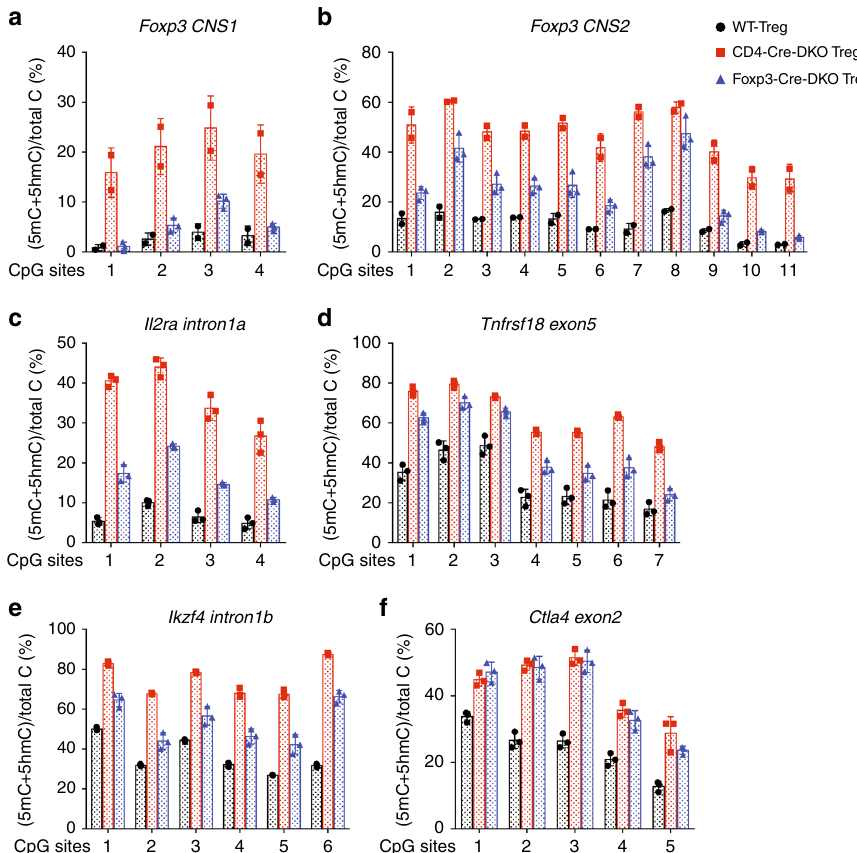
Fig. 3 DNA methylation status of TSDRs in WT and Tet2/3 fl / fl Foxp3 Cre DKO Treg cells. a – f DNA methylation status of TSDRs (Treg-speci fi c demethylated regions). Graphs depict the percentage of 5mC + 5hmC determined by BS-seq in peripheral Tregs in: ( a ) 4 CpGs in Foxp3 CNS1 , and ( b ) 11 CpGs in Foxp3 CNS2 , ( c ) 4 CpGs in Il2ra intron 1a , ( d ) 7 CpGs in Tnfrsf18 exon 5 , ( e ) 6 CpGs in Ikzf4 intron 1b and ( f ) 5 CpGs in Ctla4 exon 2 . Error bars show mean ± s.d. of thousands of sequencing reads from two independent experiments. Wild type (WT) Treg cells (8 – 10 weeks-old) are shown in black, CD4 Cre mediated Tet2/3 DKO Treg cells (3 – 4 weeks-old) are shown in red 12 and Foxp3 Cre mediated Tet2/3 DKO Treg cells (8 – 10 weeks-old) are shown in and a fold change ≥ 1.5, 2073 genes were differentially expressed, the level of active caspase-3, an early stage apoptosis marker, in with 1449 genes being upregulated and 624 genes being Treg cells from Tet2/3 fl / fl Foxp3 Cre mice compared to WT mice downregulated in Tet2/3 DKO Treg cells compared to WT Treg (Supplementary Fig. 10). Analysis of the TCR repertoire using cells (Supplementary Fig. 8a). A handful of them overlapped with RNA-seq reads mapping to the CDR3 region at Tcrb showed the differentially expressed genes from Tet2/3 DKO vs WT Treg greater clonal expansion in both Treg cells and CD4 + Foxp3 − cells isolated from Tet2/3 fl / fl Foxp3 Cre compared to WT mice cells isolated from pooled spleen and pLNs (Supplementary (Supplementary Fig. 11 and Supplementary Data 4 and 5), Fig. 8b). IPA analysis of the differentially expressed genes suggesting antigen-driven expansion. indicated that similar canonical pathways were affected, including Compared to WT mice, expression of genes involved in Tfh genes involved in cell cycle, DNA damage, immune cell function, differentiation, including Gzmb , Pdcd1 , Bcl6 , Maf , Cxcr5 , and and cancer development (Supplementary Fig. 8c and Supple- Il21 , was unaltered or only mildly increased in Treg cells isolated mentary Data 3). from the Tet2/3 fl / fl Foxp3 Cre mouse with moderate splenomegaly (DKO), but markedly increased in Treg cells isolated from the littermate mouse with more severe splenomegaly (DKO*) (Fig. 4e, left panel). Genes related to Tfh and Th17 cell differentiation (Il17a, Il17f, Rorc) in CD4 + Foxp3 – T cells displayed a similar trend (Fig. 4e, right panel), indicating that both CD4 + Foxp3 + Treg cells and CD4 + Foxp 3 − T cells from Tet2/3 fl / fl Foxp3 Cre mice displayed skewing to Tfh and/or Th17 lineages in a manner that correlated directly with disease severity. The skewed Tfh and/or Th17 lineages were also observed in Treg cells and CD4 + Foxp3 – T cells isolated from mLN of Tet2/3 fl / fl Foxp3 Cre mice (Supple- mentary Fig. 8e). In WT mice at steady state, fewer than 5% of CD4 + TCR β + T cells from spleen and mLNs stained positive for the Tfh signature molecules CXCR5 and PD-1, but this percentage was